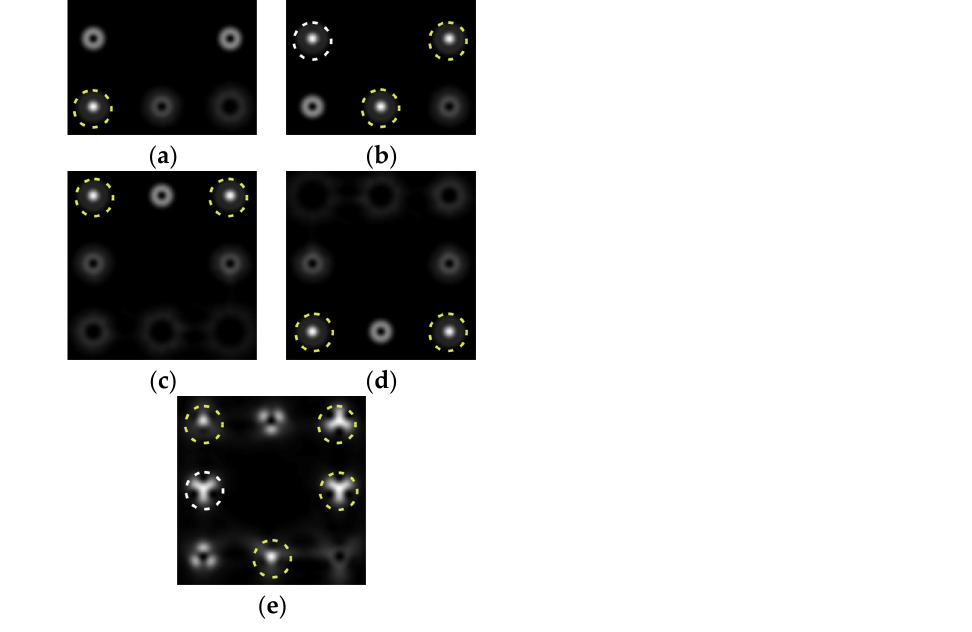
Figure 3. Action of an eight-channel DOE, matched with optical vortices in the analysis of vortex fields with cylindrical polarization of the first order ( p = 1): ( a ) m = 0, ( b ) m = − 1, ( c ) m = 2, ( d ) m = − 2, and ( e ) m = − 1, 2.